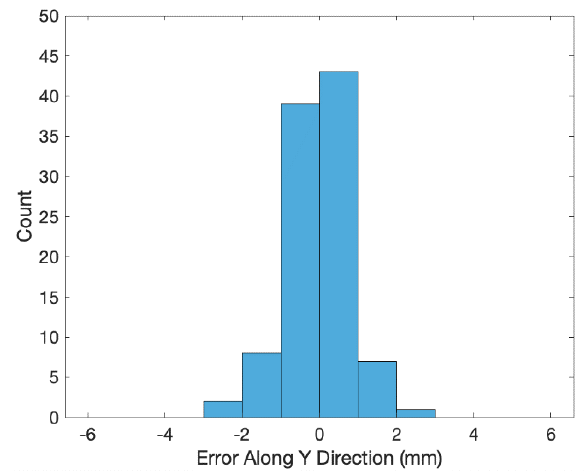
Figure 4. Histogram of errors along Y direction between the end effector coordinates and transformed coordinates of the 3D scanned positions.